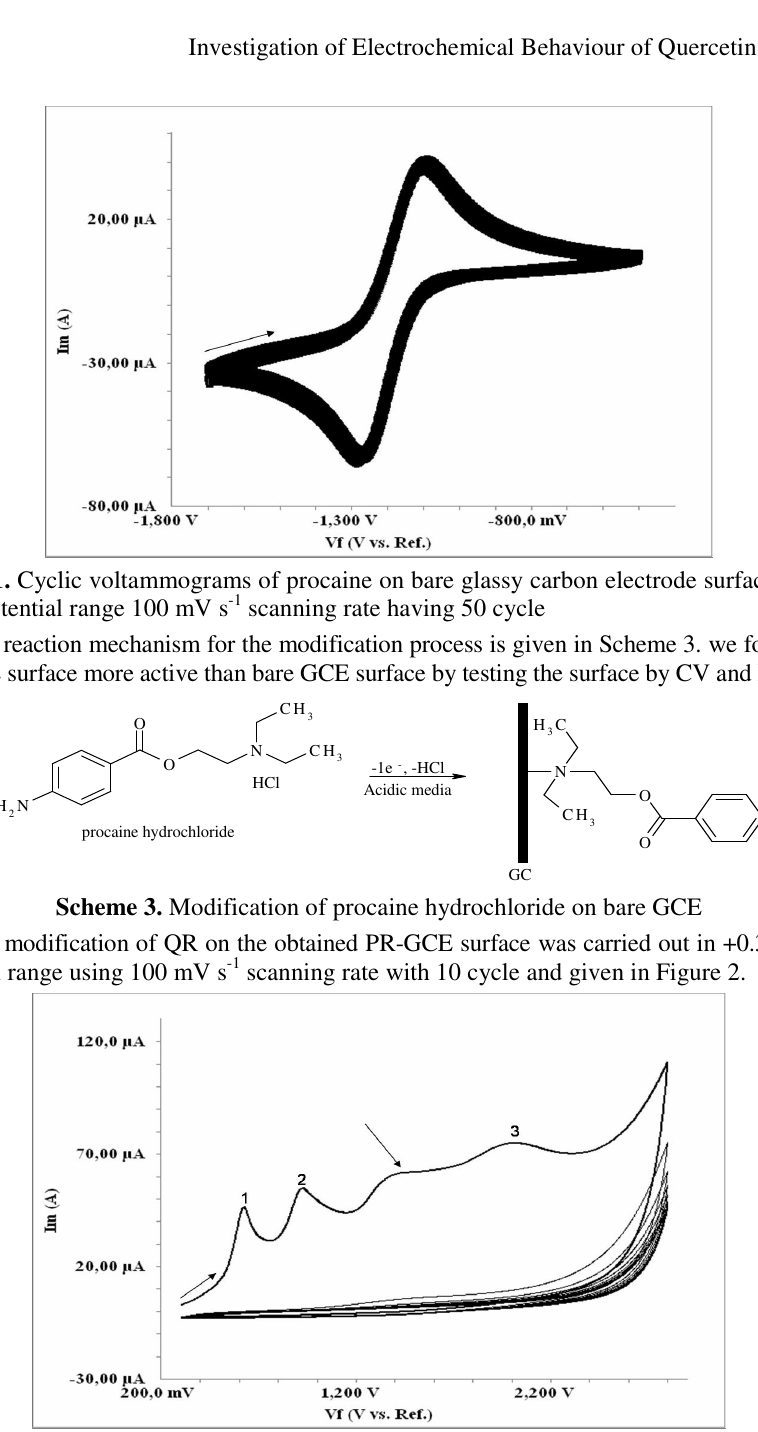
Figure 2. Cyclic voltammograms of quercetin on procaine modified glassy carbon electrode